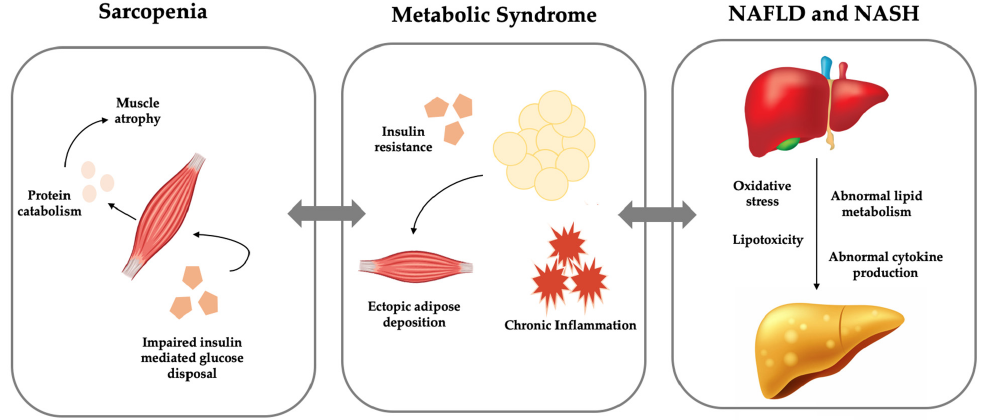
Figure 1. Visual representation of interplay between metabolic syndrome, non-alcoholic fatty liver disease (NAFLD), and sarcopenia.